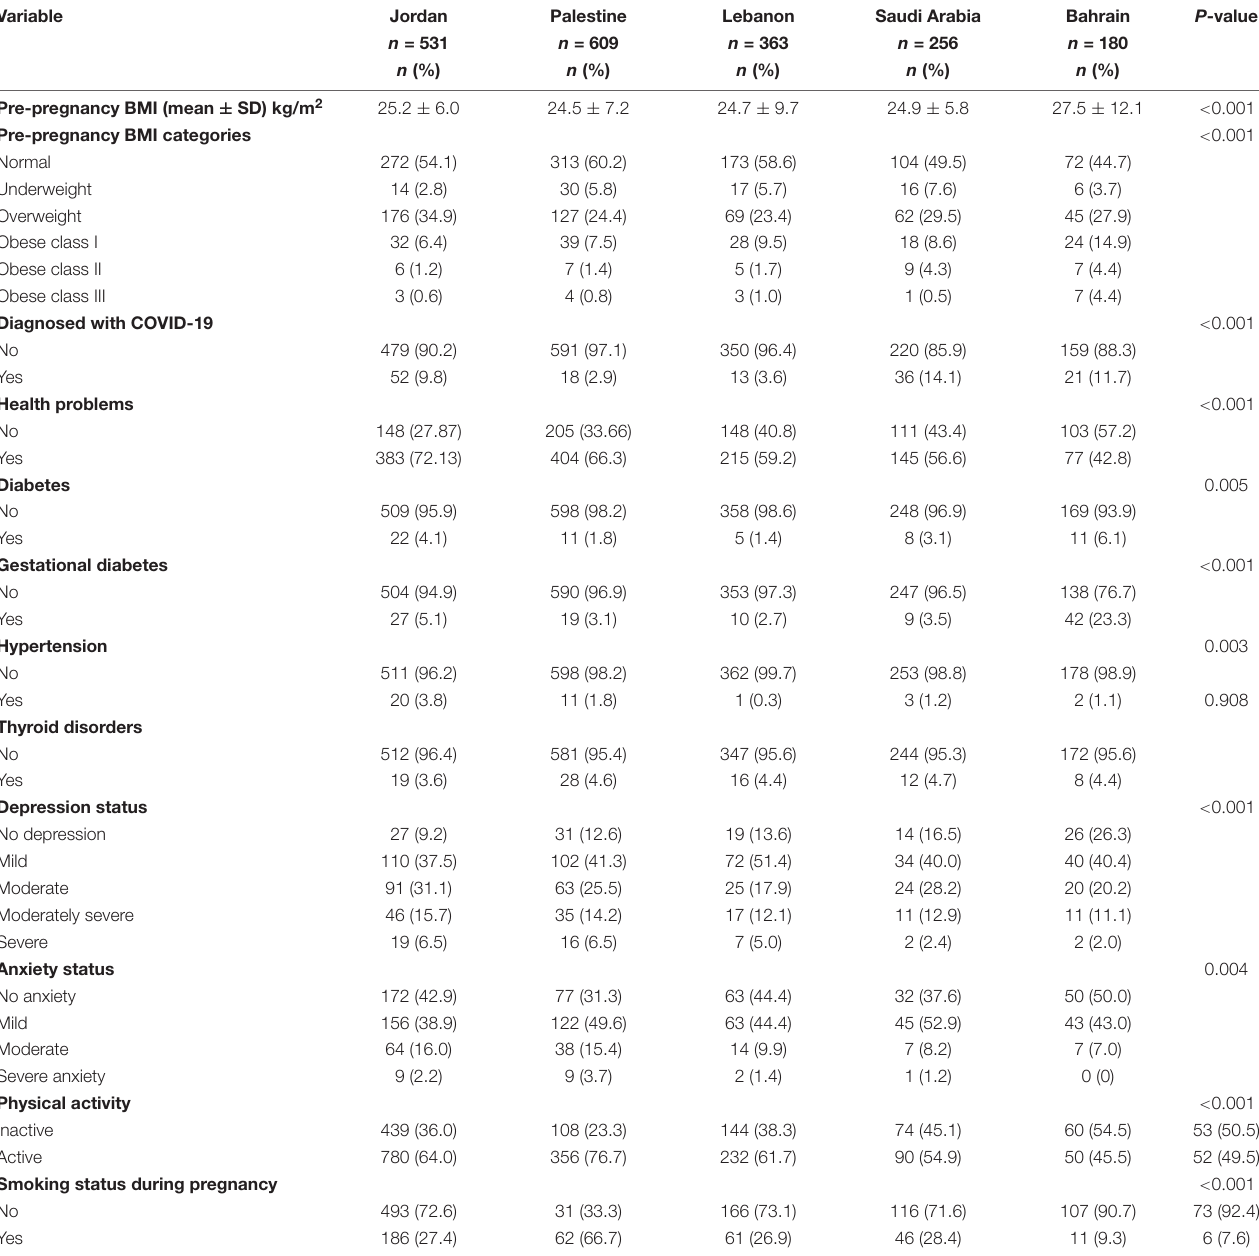
TABLE 2 | Health characteristics of the study participants, by country.